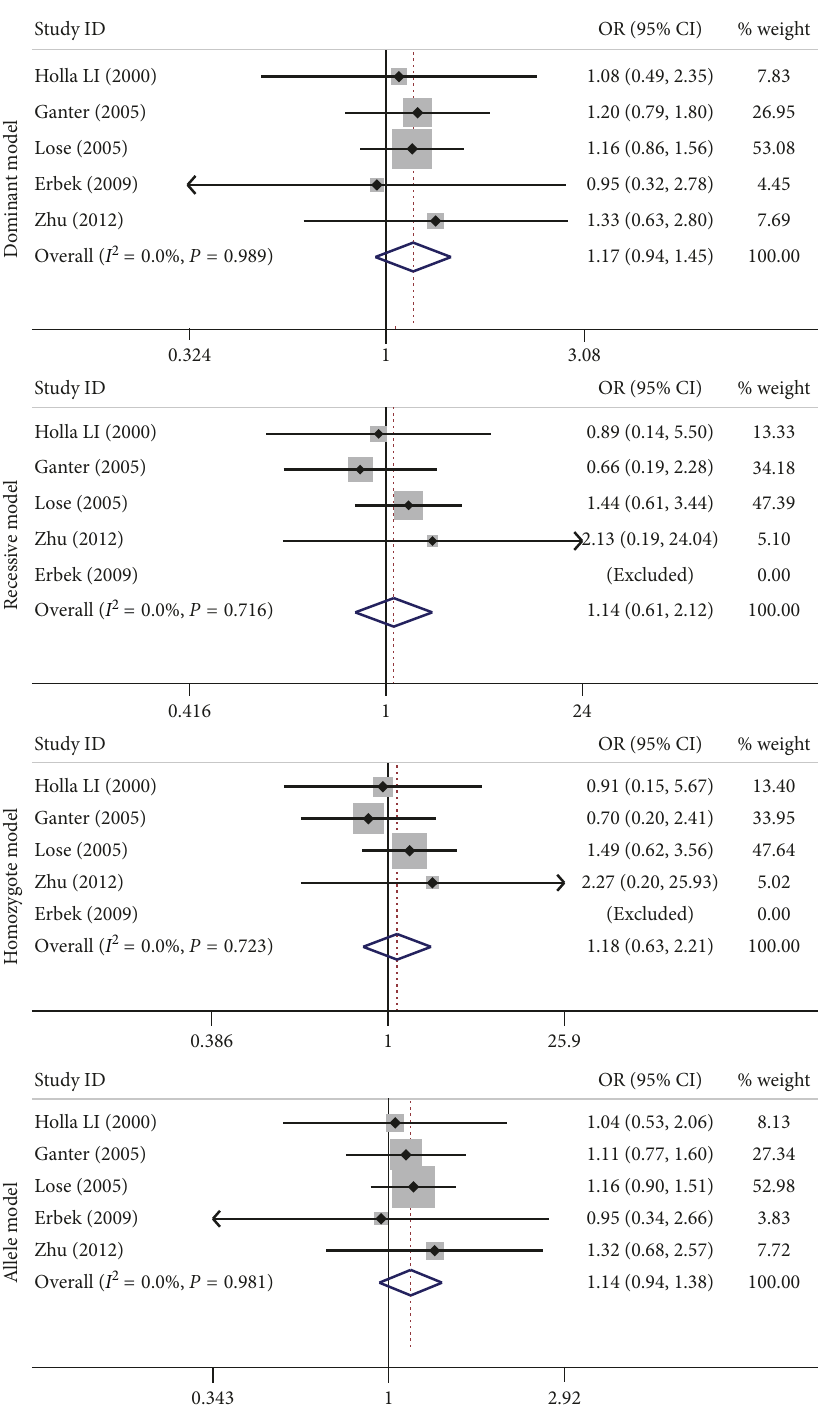
Figure 2: Forest plots of the association between the MMP-9 − 1562 C > T, rs3918242 polymorphism and risk of asthma in the dominant model, recessive model, homozygote model, and allele model